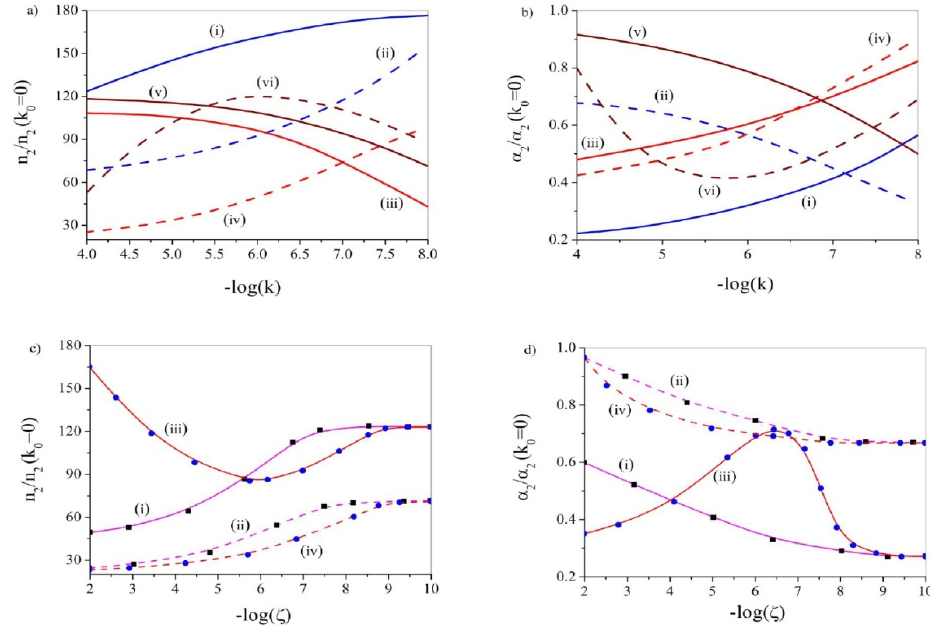
Figure 15. Plots of ( a ) CF for RI vs. − log(k) and ( b ) CF for AC vs. − log(k): (i) devoid of noise and under OPA, (ii) devoid of noise and under EPA, (iii) with ADWN and under OPA, (iv) with ADWN and under EPA, (v) with MLWN and under OPA and (vi) with MLWN and under EPA. Plots of ( c ) CF for RI vs. − log( ζ ) and ( d ) CF for AC vs. − log( ζ ): (i) with ADWN and under OPA, (ii) with ADWN and under EPA, (iii) with MLWN and under OPA and (iv) with MLWN and under EPA.